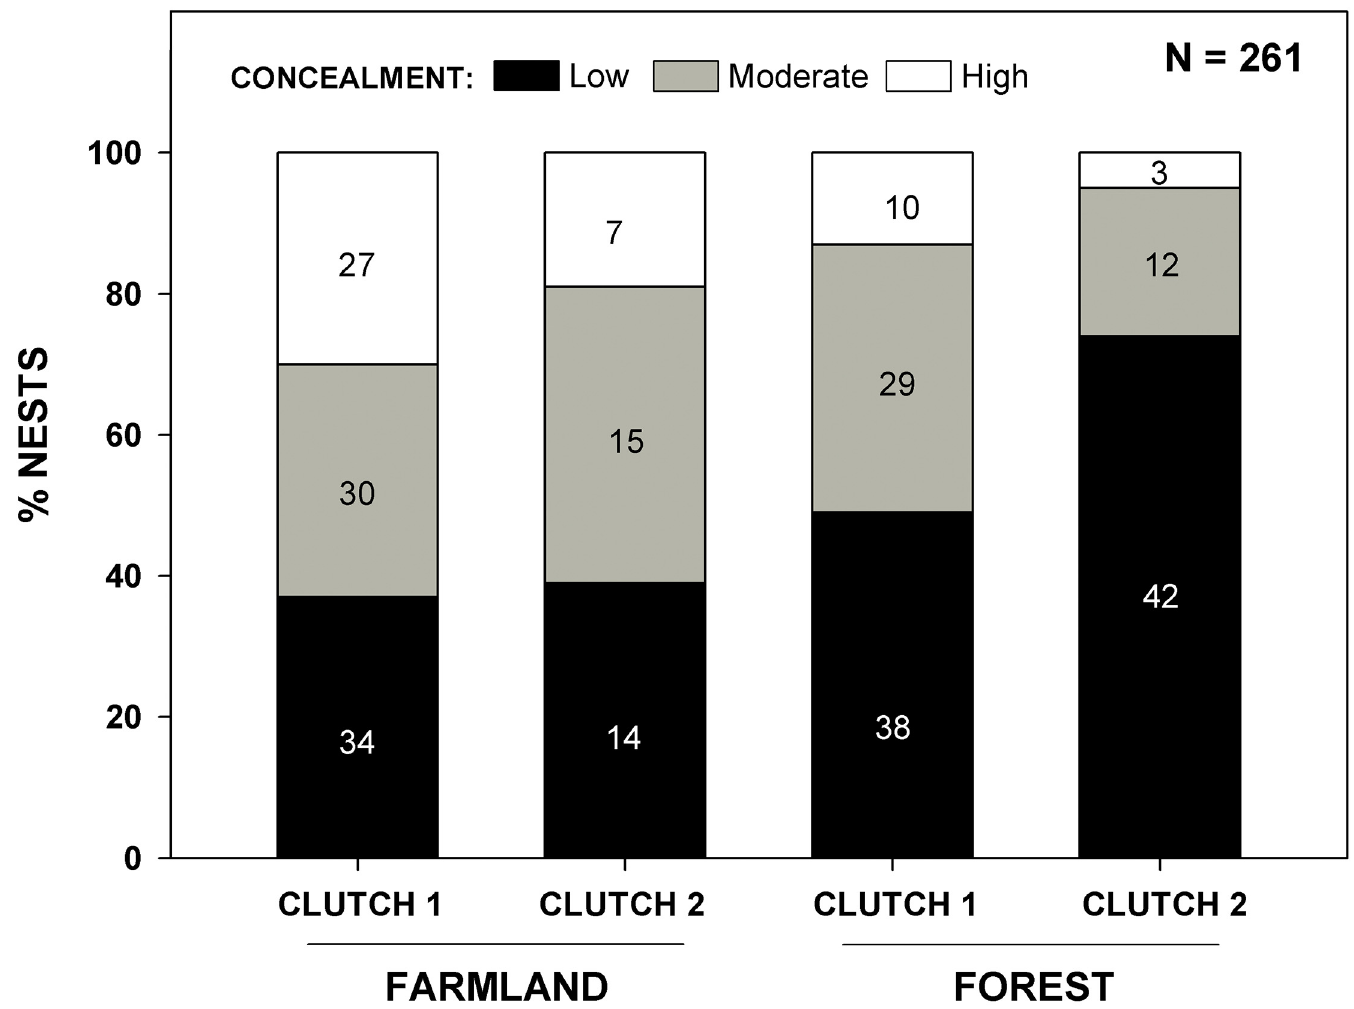
Fig 2. Nest concealment in farmland and forest. Percentage of nests in farmland and forest habitats and in first (clutch 1) and replacement (clutch 2) clutches assigned to one of three categories of nest concealment: low, moderate and high concealment. Sample sizes refer to the number of nests used to measure nest